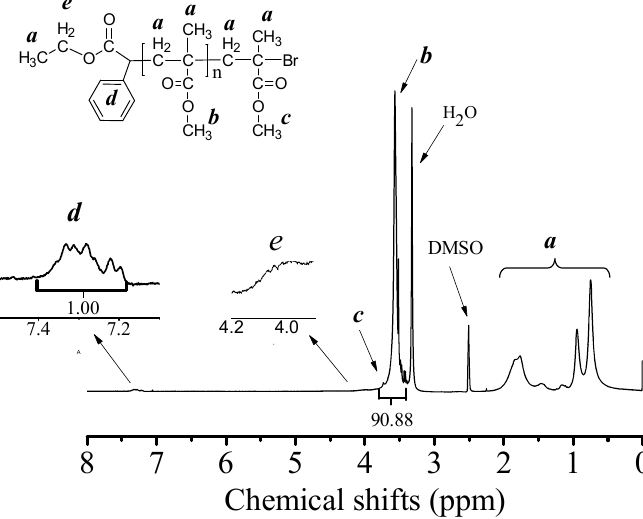
Figure 4. 1 H NMR spectrum of the resultant PMMA ( M n,GPC = 4250 g/mol, M w / M n = 1.22) via TPSC-based ICAR ATRP of MMA using DMSO- d 6 as the solvent and TMS as the internal standard.